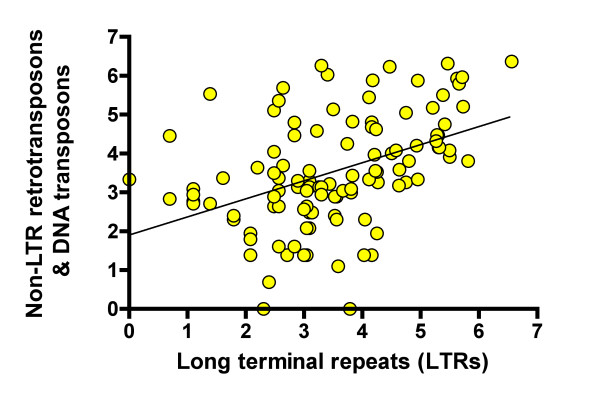
Correlation between unrelated TE families in diverse groups of species. Vertical axis: natural logarithms of cumulative numbers of non-LTR retrotransposon and DNA transposon families. Horizontal axis: natural logarithms of cumulative numbers of LTR retrotransposon families.